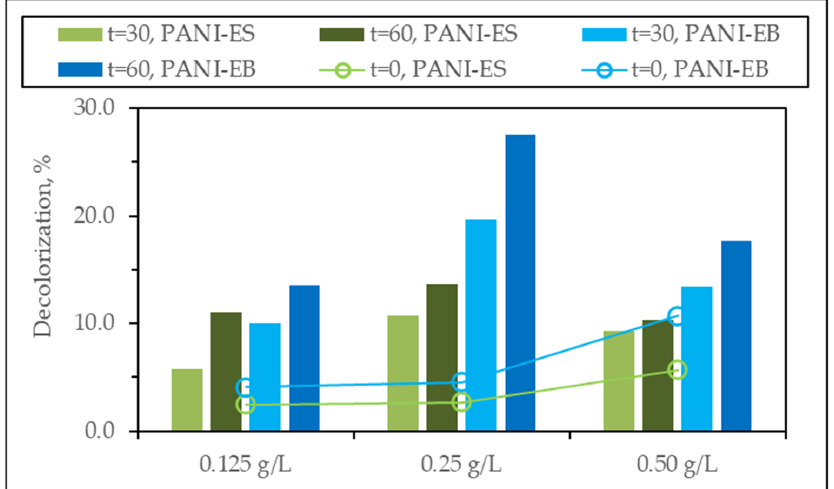
Figure 9. Photocatalytic degradation of MB upon use of PANI-ES and PANI-EB: Dose effect. From a general perspective, dose effect of both PANI specimens reflected the same increasing trend with respect to increase from 0.125 g/L to 0.25 g/L followed by a decrease upon use of 0.50 g/L. Lower doses such as 0.125 g/L exerted specimen specific and irradi- ation time dependent variations, such as decolorization attained by use of PANI-ES in 60 min which were slightly higher than PANI-EB in 30 min. Decolorization efficiencies at- tained by using PANI-EB were higher compared to PANI-ES (<15%) irrespective of the dose amount most possibly due to the enhanced electrostatic attractions under both irra- diation periods. The lowest decolorization was attained upon use of 0.125 g/L PANI-ES in 30 min and the highest decolorization was observed upon use of 0.25 g/L PANI-EB. Figure 10. Photocatalytic degradation of MB upon use of sole ZnO: Dose effect.